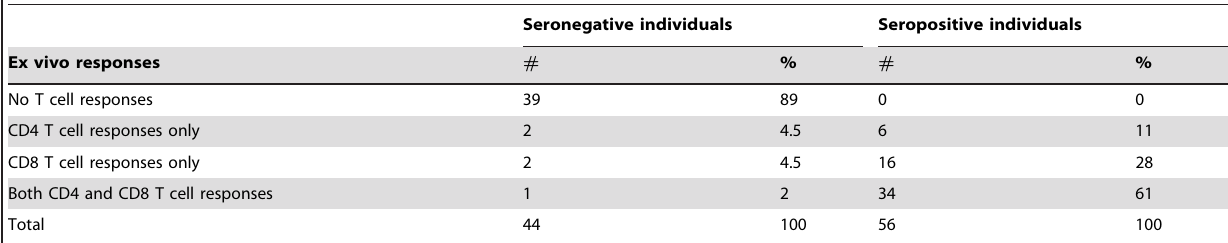
Table 1. Ex vivo